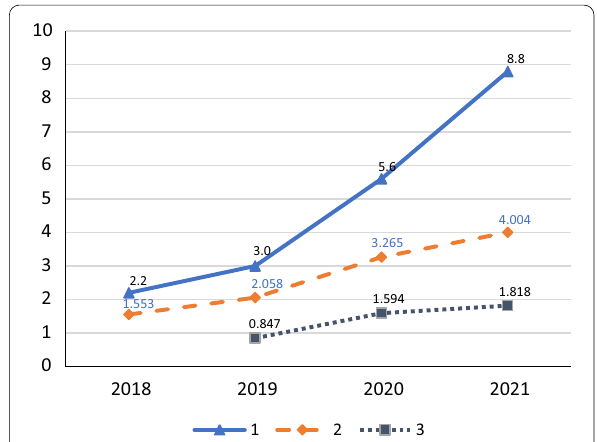
Scopus CiteScore, =